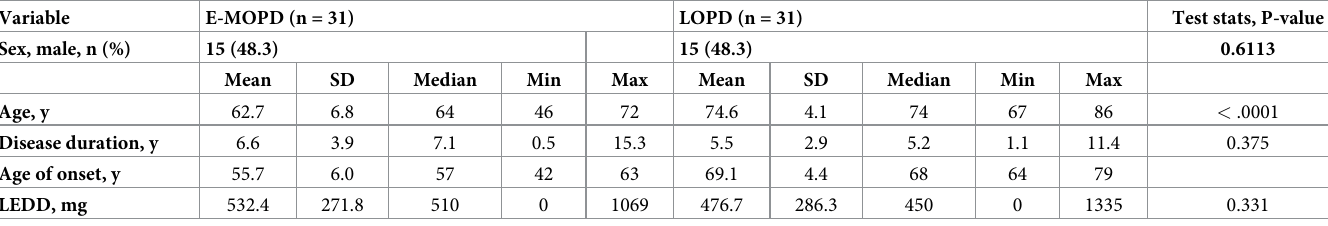
Table 1. Demographic variables and clinical information during MRI imaging.